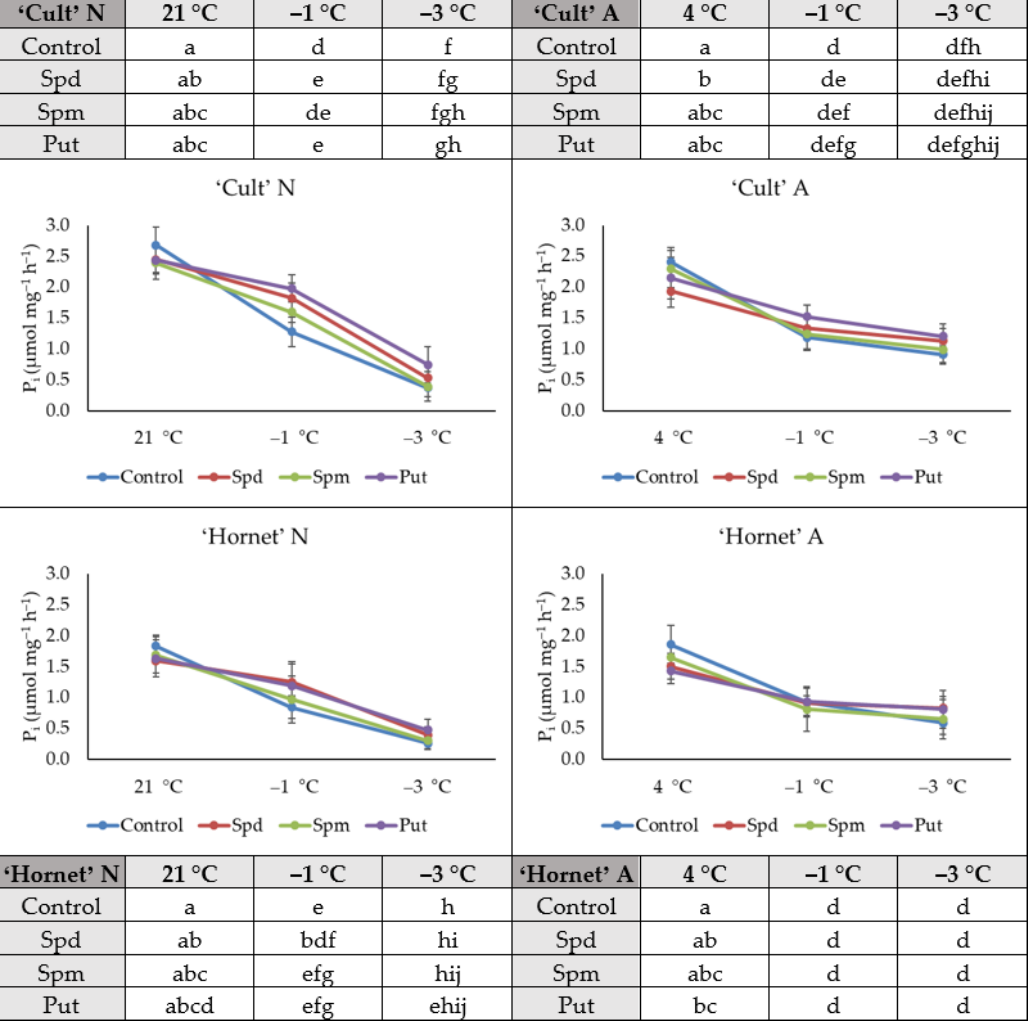
Figure 2. The effect of PA application, cold acclimation (4 °C, 4 days), and increasing cold treatment (from –1 to –3 °C, 2 days) on winter oilseed rape H + -ATPase activity. Error bars represent the standard deviation of the mean. Control, Spd, Spm, and Put indicate the type of application. Capital letters N and A indicate non-acclimation and acclimation, respectively. Different lowercase letters indicate statistically significant difference ( P < 0.05).